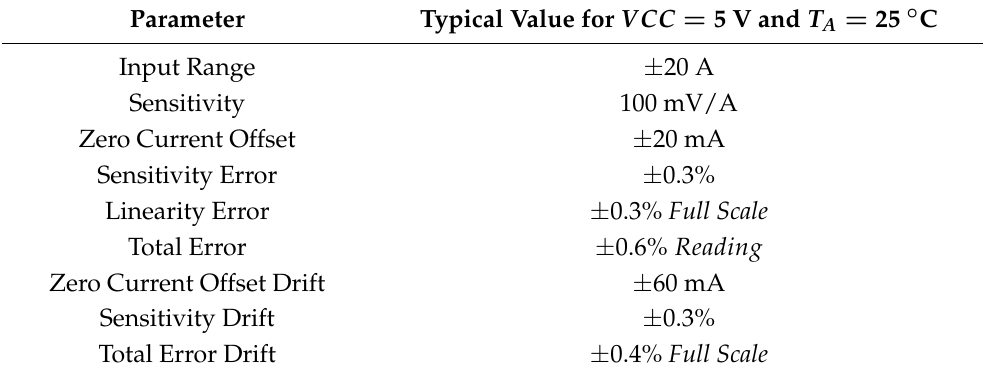
Table 1. MCR 1101-20-5 sensor’s